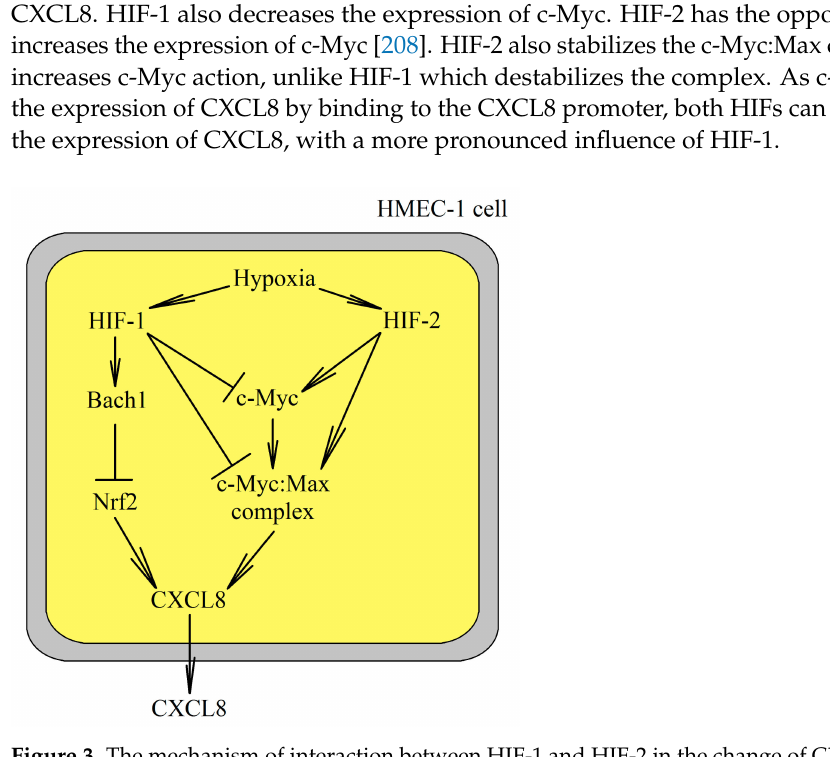
Figure 3. The mechanism of interaction between HIF-1 and HIF-2 in the change of CXCL8 expression in HMEC-1 cells. HIF-1 reduces CXCL8 expression in HMEC-1 cells due to an increase in Bach1 expression, which reduces erythroid 2-related factor (Nrf2) activation. HIF-1 also reduces the expression of c-Myc and destabilizes the c-Myc:Max complex. HIF-2 increases the expression of CXCL8 in these cells, which is related to an increase in c-Myc expression and stabilization of the c-Myc:Max